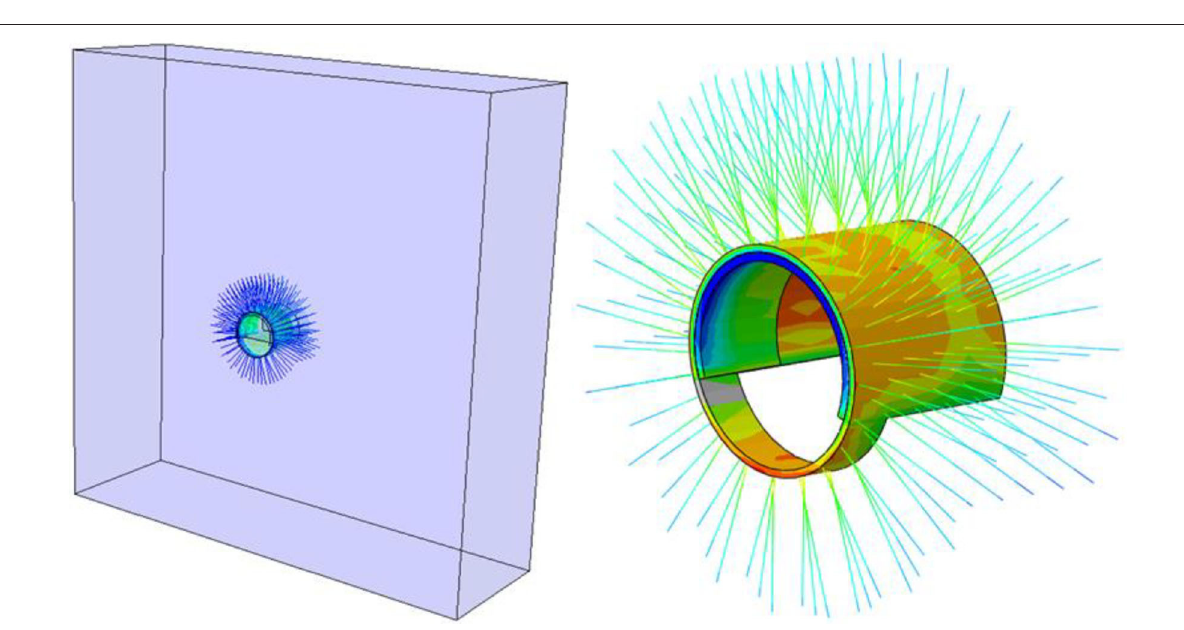
cause data distortion due to component wire breakage caused by construction.